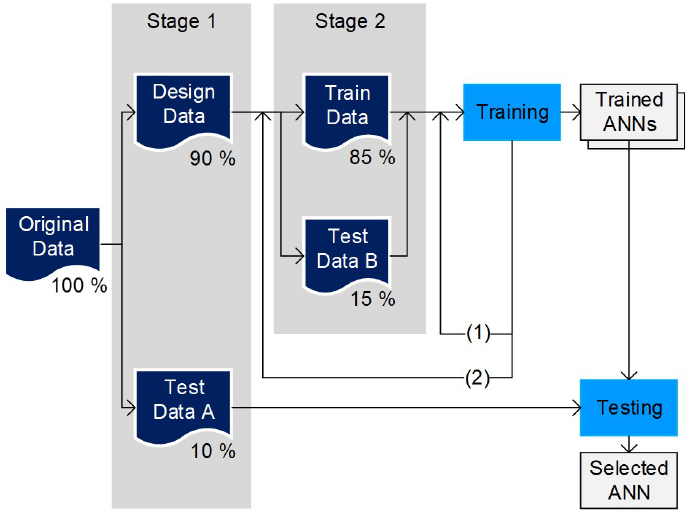
Figure 4. Data division scheme and training strategy. Taken from N. Delgado Otalvaro et al.